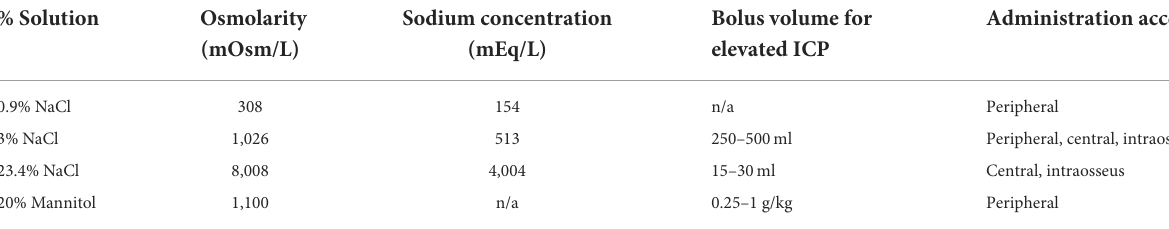
TABLE 1 Properties of hyperosmolar agents for treatment of elevated intracranial